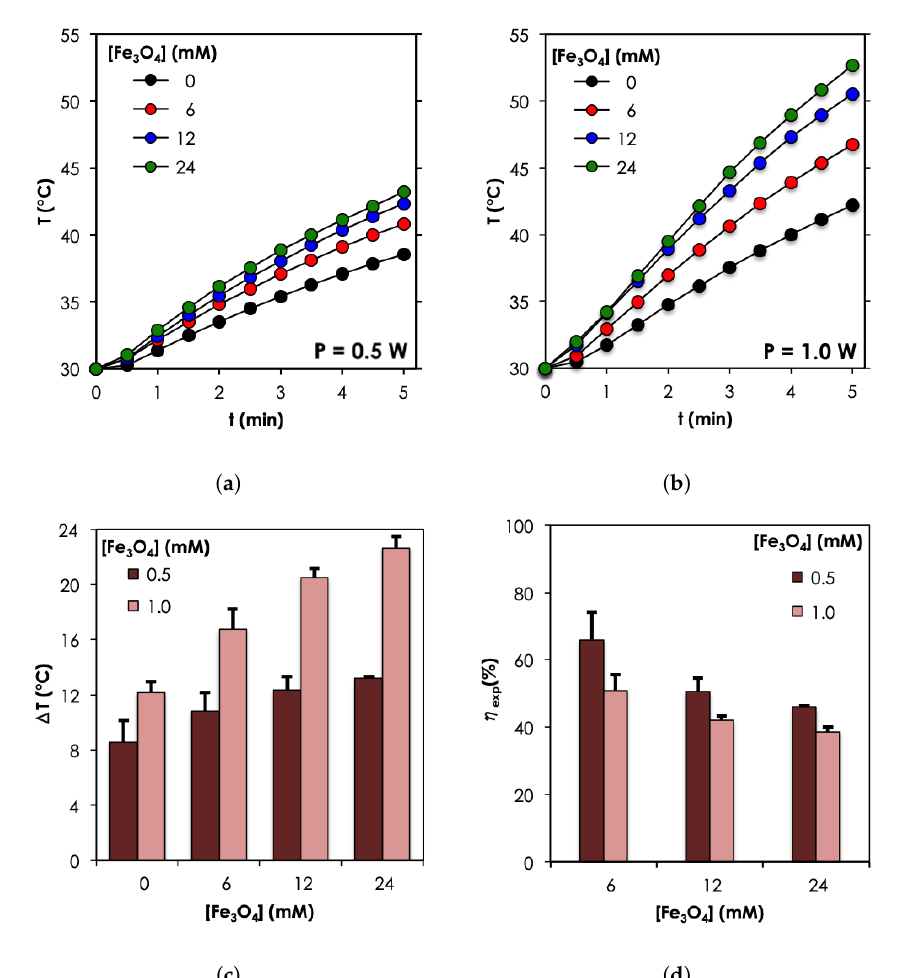
Figure 2. Photothermal characterization results. Temporal response curves for different concentrations after 5 min of irradiation with laser powers: ( a ) P 0 = 0.5 W and ( b ) P 0 = 1.0 W. Comparison of the corresponding ( c ) temperature change ( ∆ T ) and ( d ) experimental photothermal conversion efficiency ( η exp ) as a function of laser power. Error bars: